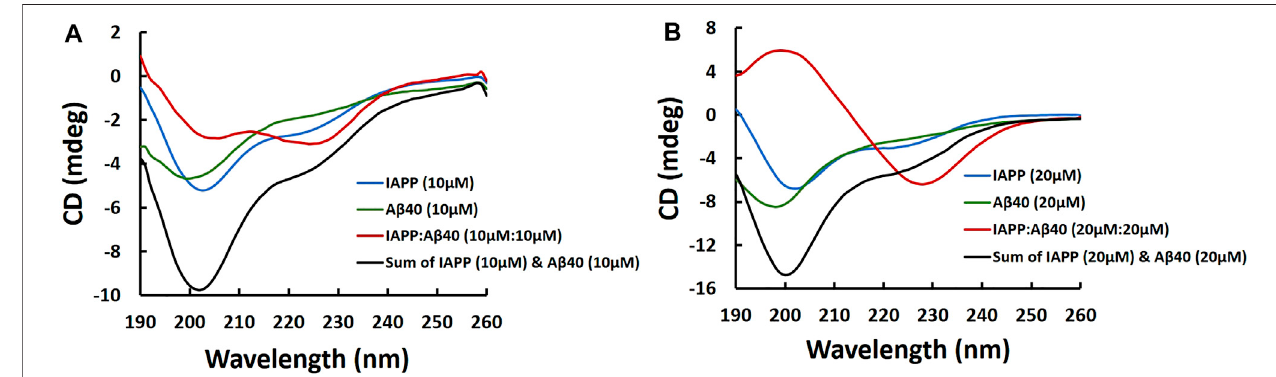
FIGURE3| Far-UVCDspectraofsamplescontainingIAPPalone,A β 40aloneandIAPP-A β 40(equimolarmixture)preparedatincreasingconcentrationsasshown in (A) and (B) .Freshsampleswerepreparedbydilutingpeptides fromtheirHFIPstocksintothebuffer(10 mMNaH 2 PO 4 ,pH7.4)and CDmeasurements wereacquired